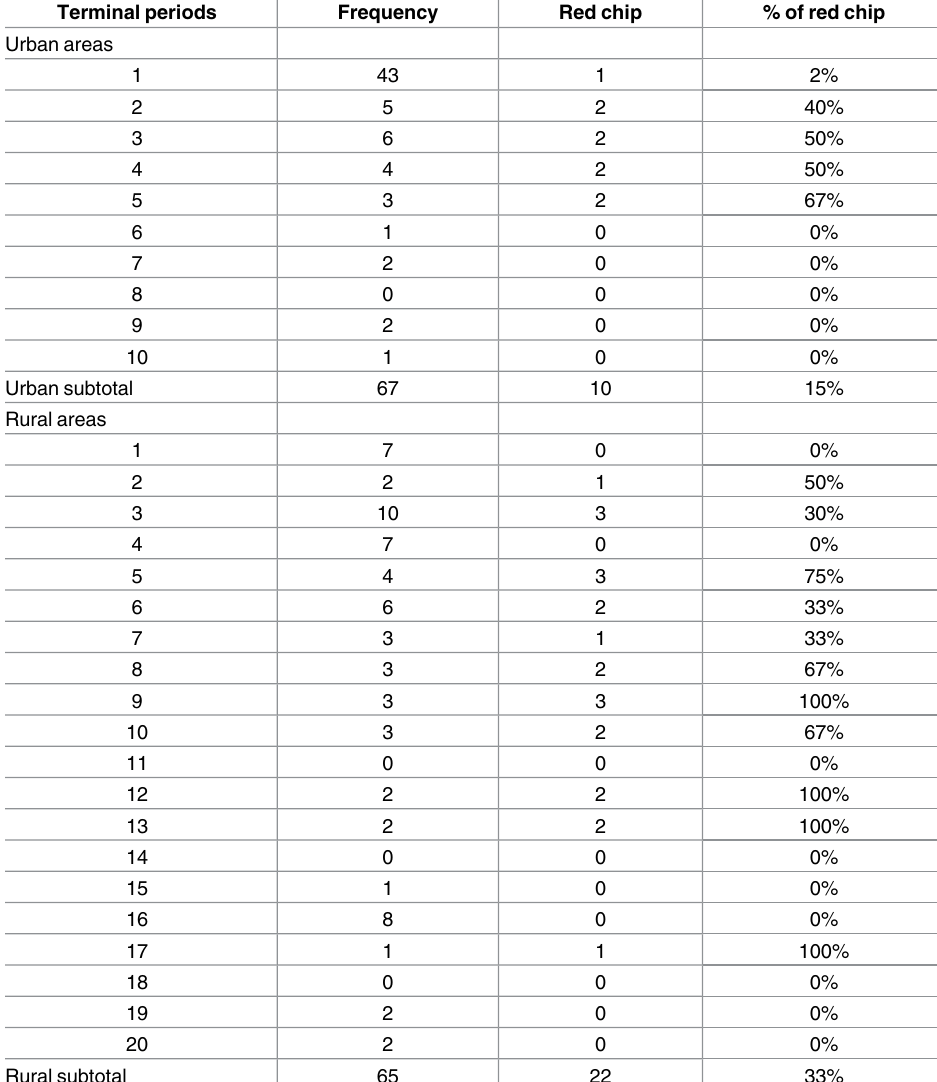
Table 2. Terminal periods across the rural and urban